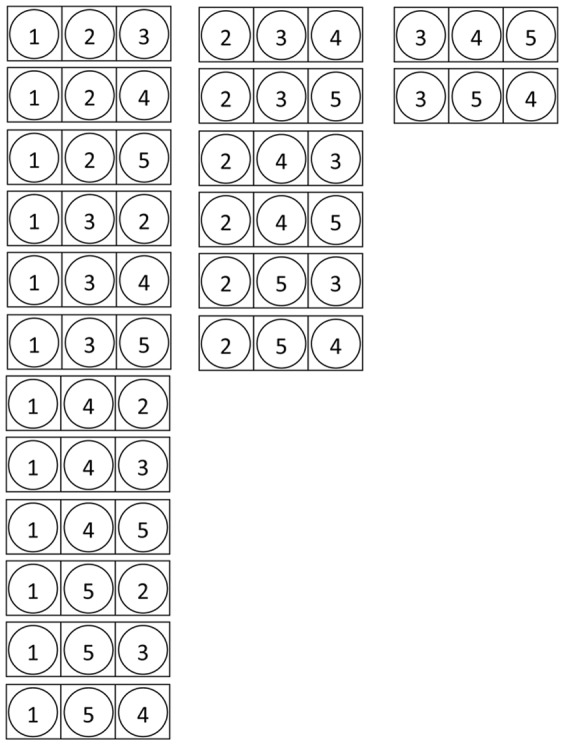
Cyclic rotation symmetry.Enumeration of all possibilities to map 5 network nodes on 3 motif nodes that are part of a cyclic rotation. The squares represent motif nodes, the circles represent network nodes. Once a network node is mapped on the ‘first’ motif of the symmetry, it will never be mapped on the other nodes of the symmetry. For the other motif nodes of the symmetry, all possibilities still need to be explored.